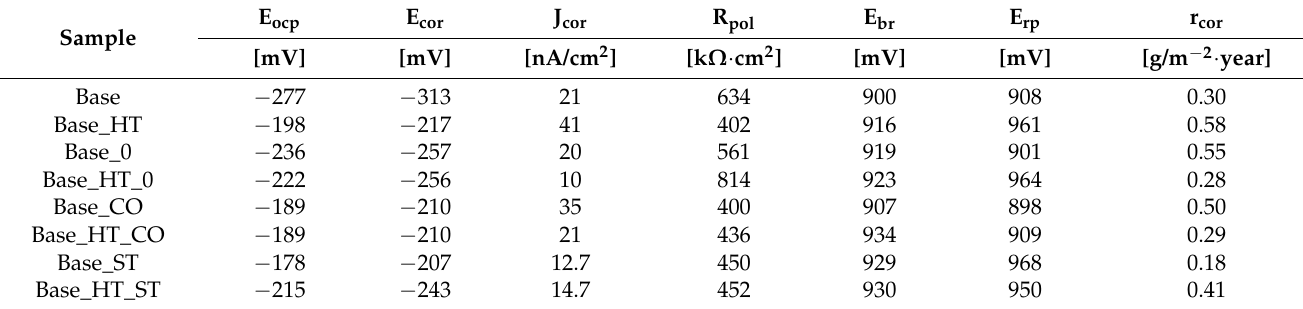
Abbreviations are as follows: Base—CoCrMoW alloy, HT—heat treatment, 0—laser beam autogenous welding (without filler metal), ST—welded with stainless steel wire, CO—welded with CoCr